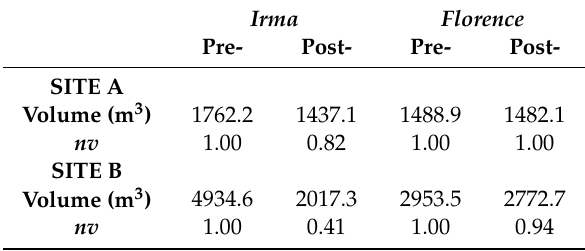
Table 2. Dune volumes (m 3 and normalized volumes ( nv )) for pre- and post- Irma and Florence for Sites A and